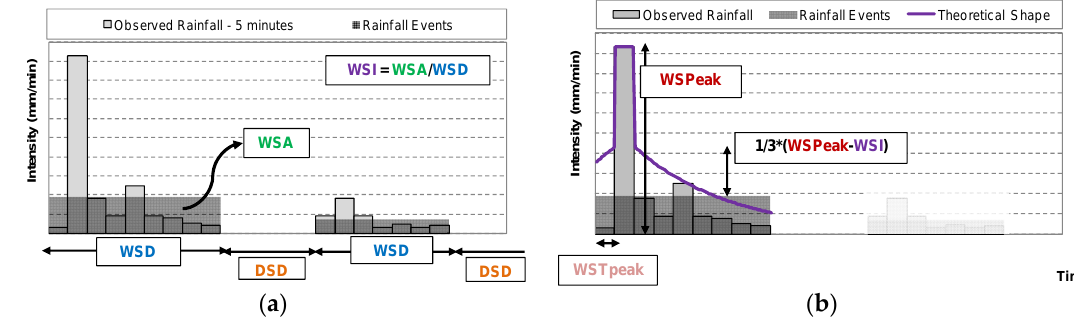
Figure 1. Components of the ( a ) external and ( b ) internal structures of the precipitation model.